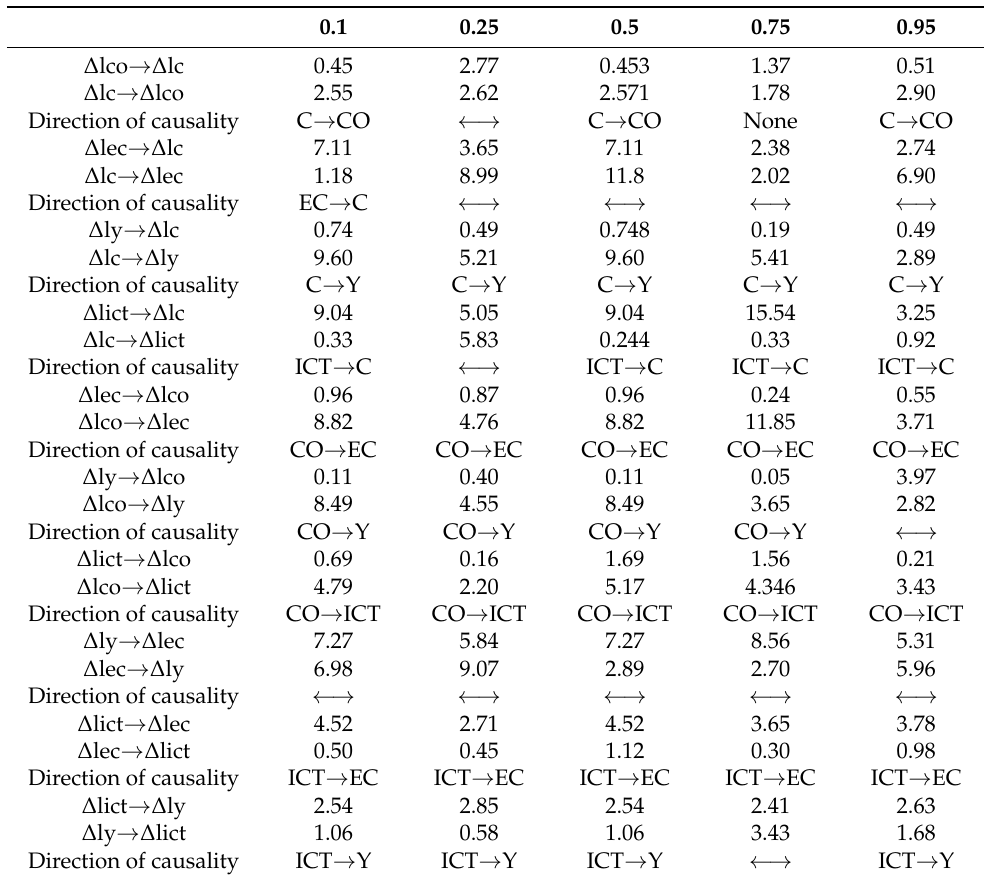
Table 9. Causality